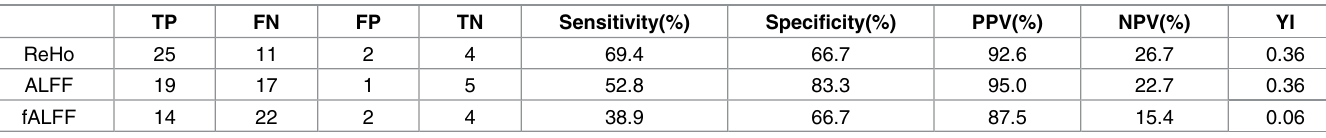
Table 5. Performanceof ReHo, ALFF, and fALFF for EZ localization.